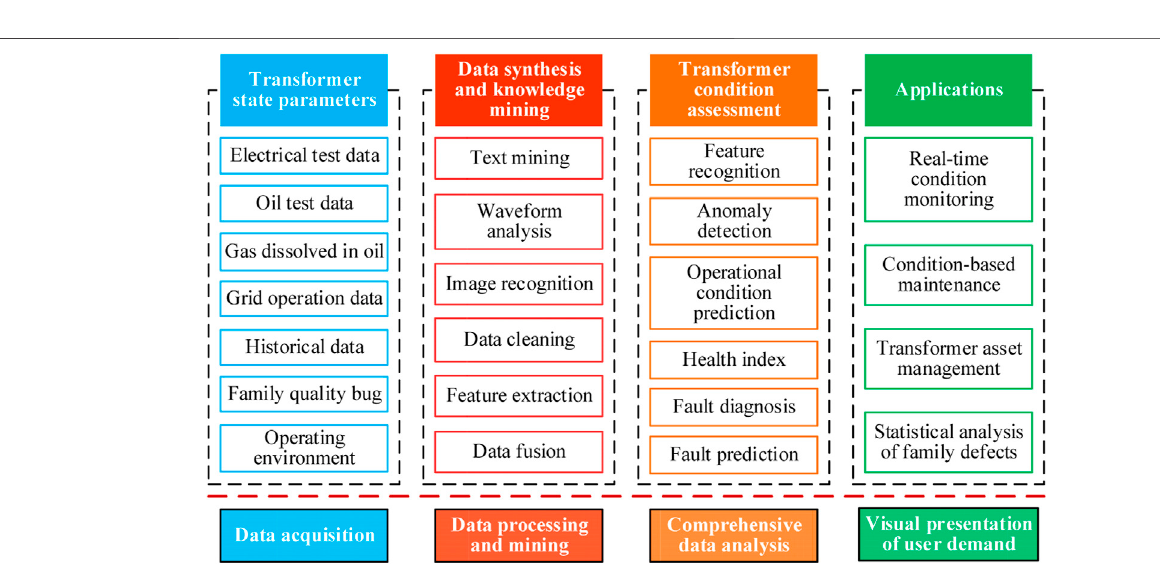
FIGURE 5 | Flowchart of transformer condition assessment.